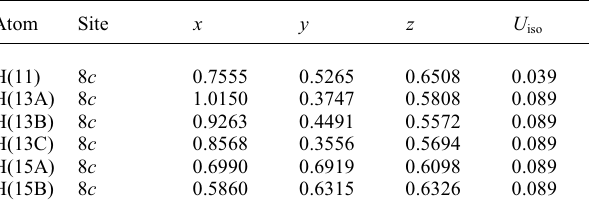
Table 3. Atomic coordinates and displacement parameters (in Å 2